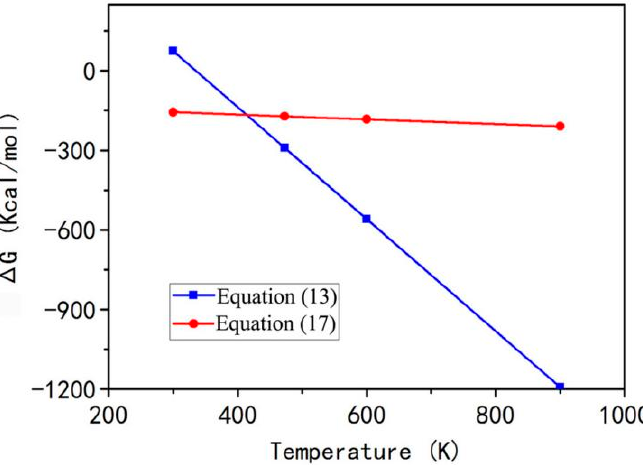
Figure 2. Δ G for various reaction temperatures for Equations (13) and (17) . Figure 2. ∆ G for various reaction temperatures for Equations (13) and